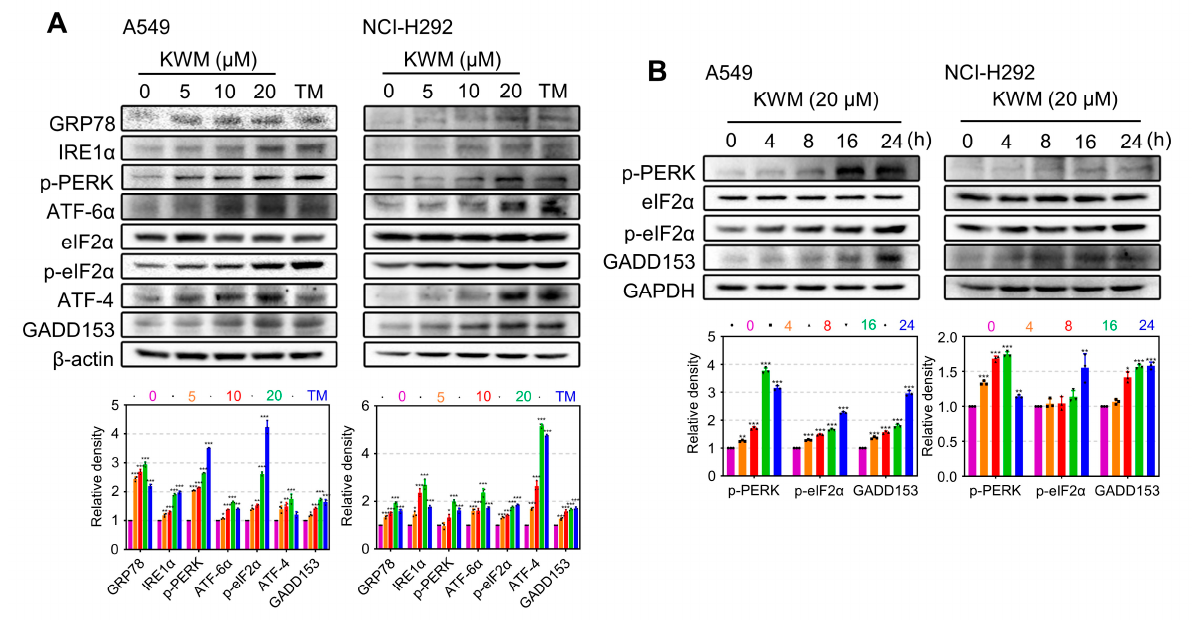
Figure 6. KWM induced ER stress and UPR in A549 and NCI-H292 cells. ( A ) Cells were treated with KWM for 16 h, cell lysates were subjected to immunoblotting for ER stress and UPR-associated proteins. Tunicamycin (TM, 3 µ M) treatment was used as positive control. ( B ) Cells were treated with 20 µ M KWM for different times, several representative proteins of UPR pathway were detected by immunoblotting. Values were expressed as mean ± SD, n = 3. * p < 0.05, ** p < 0.01, and *** p < 0.001 versus untreated groups.